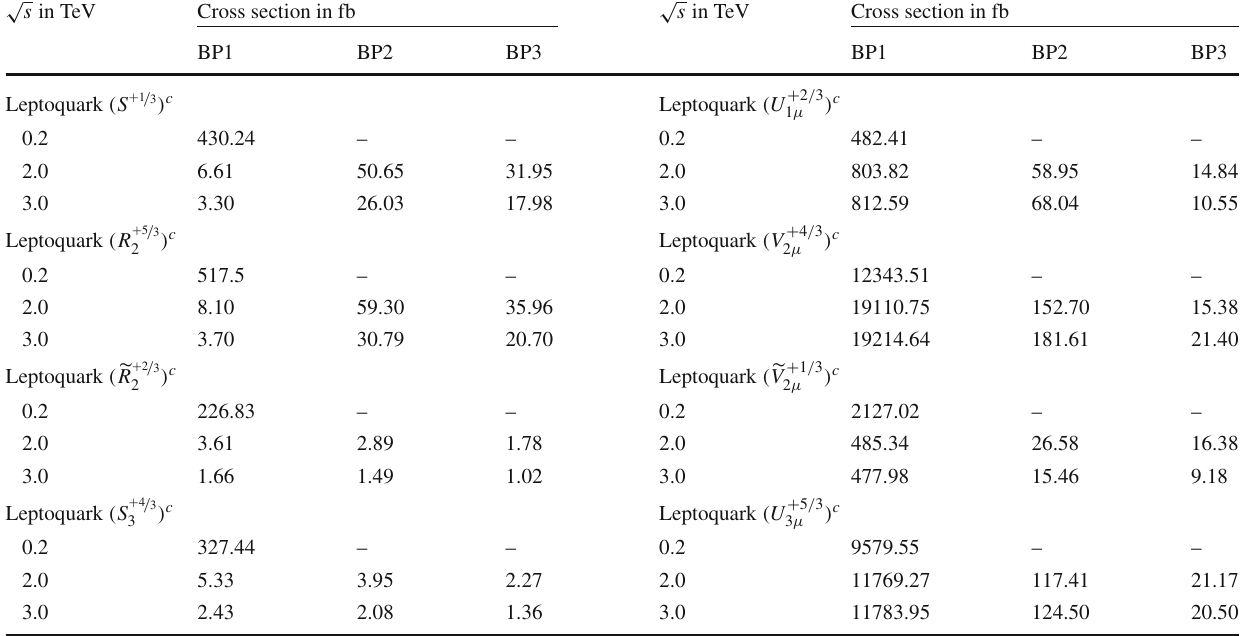
Table 3 Production cross sections for the chosen leptoquarks at e – γ collider for the benchmark points listed in Table 2 at center of momentum energies of 200 GeV, 2 TeV and 3 TeV √